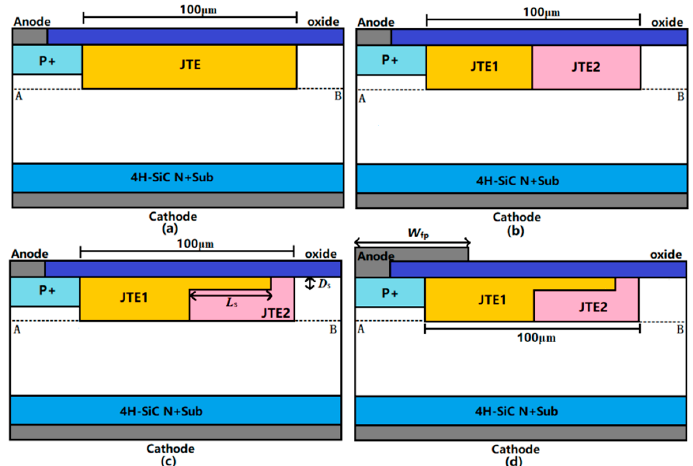
Figure 1. Schematic structures of ( a ) single-zone junction termination extension (SZ-JTE); ( b ) double-zone JTE (DZ-JTE); ( c ) Step-DZ-JTE; ( d ) Step-DZ-JTE with field plate (FP). The n- epi-layer is 30- μ m thick and 2 × 10 15 cm − 3 doped.